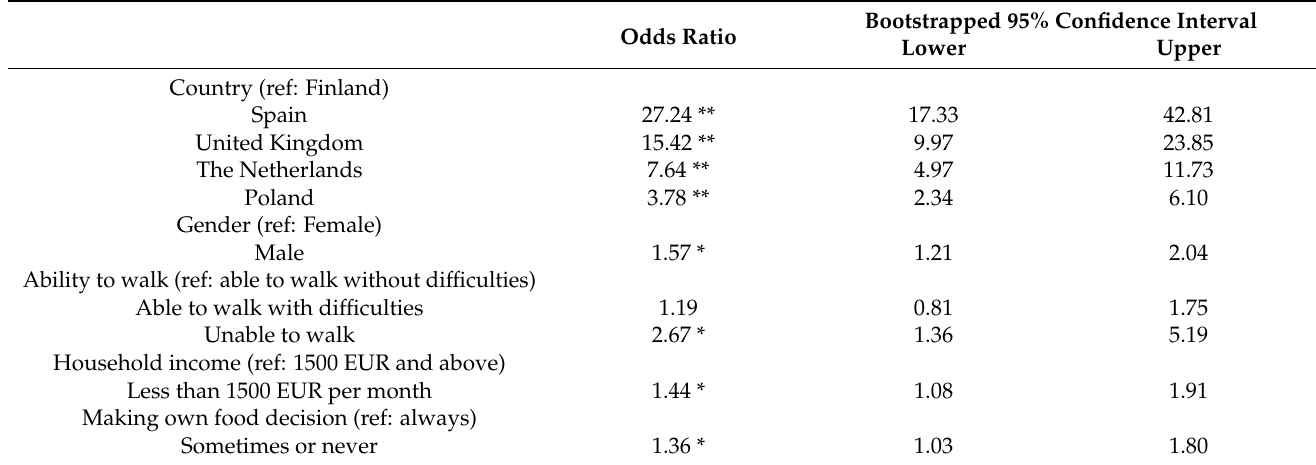
Table 3. Determinants of lower protein knowledge in community-dwelling adults aged 65 years and above living in five European countries ( n =